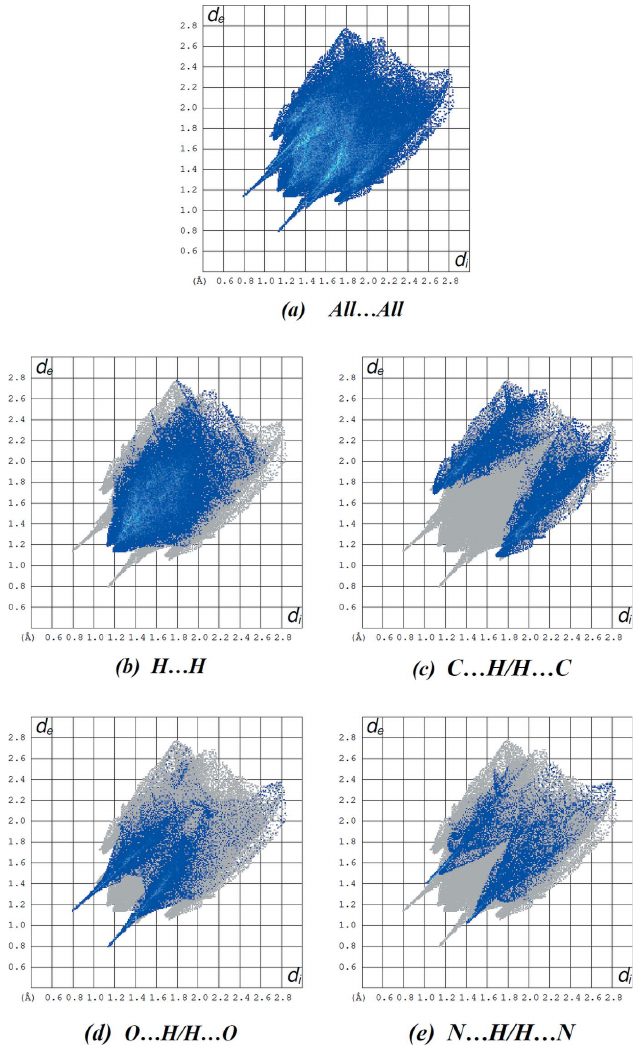
Figure 5 A view of the two-dimensional fingerprint plots for the title compound, showing ( a ) all interactions, and those delineated into ( b ) H (cid:2)(cid:2)(cid:2) H, ( c ) C (cid:2)(cid:2)(cid:2) H/H (cid:2)(cid:2)(cid:2) C, ( d ) O (cid:2)(cid:2)(cid:2) H/H (cid:2)(cid:2)(cid:2) O and ( e ) N (cid:2)(cid:2)(cid:2) H/H (cid:2)(cid:2)(cid:2) N interactions. The d i and d e values are the closest internal and external distances (in A˚ ) from given points on the Hirshfeld surface.